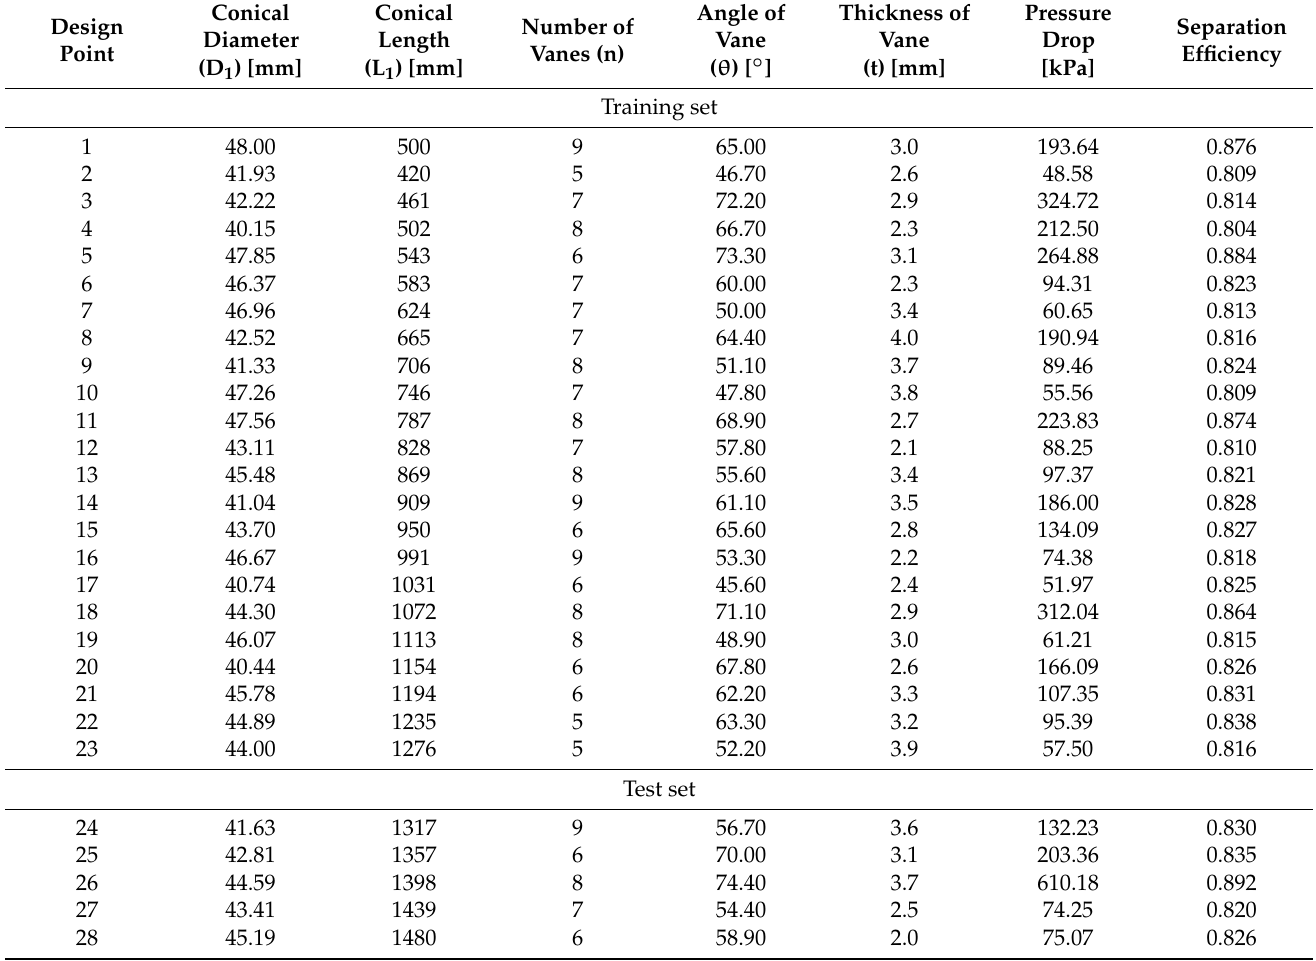
Figure 6. Tangential velocity at 2D downstream of the ISE: ( a ) at 5 vanes, ( b ) at 6 vanes, ( c ) at 7 vanes, ( d ) at 8 vanes, and ( e ) at 9 vanes.